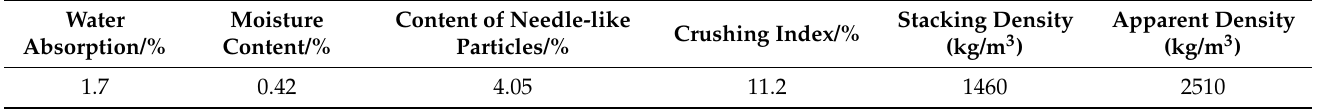
Table 3. Performance index of natural coarse aggregate.